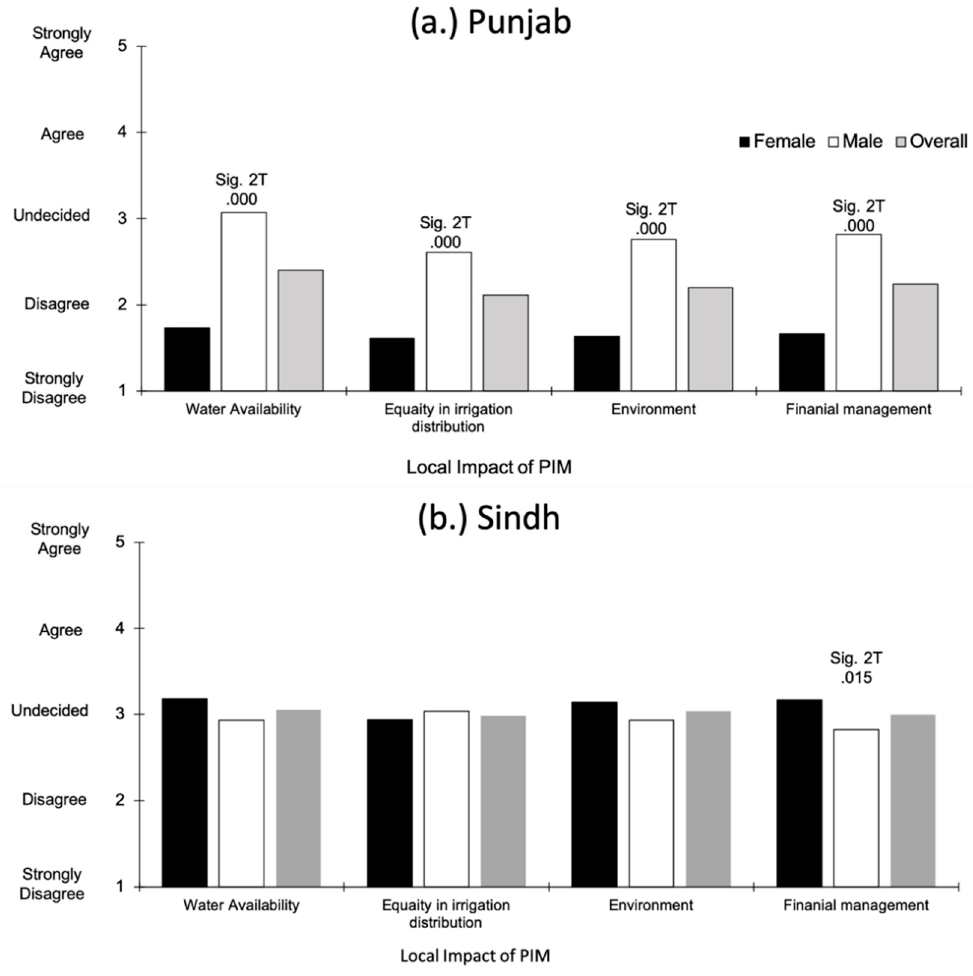
Figure 7. Comparative assessment of the specific impacts of PIM.